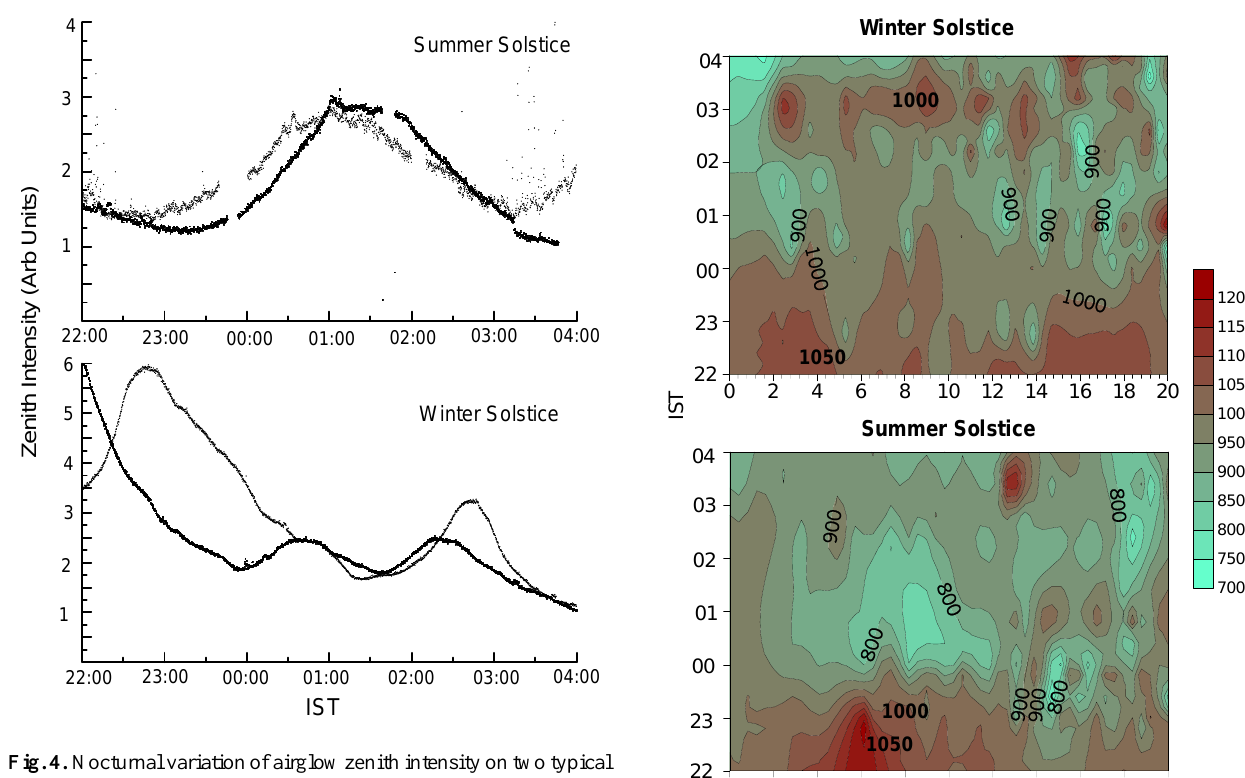
Fig. 4. Nocturnal variation of airglow zenith intensity on two typical days showing the brightness wave feature during summer solstice (top panel) and winter solstice (bottom panel).